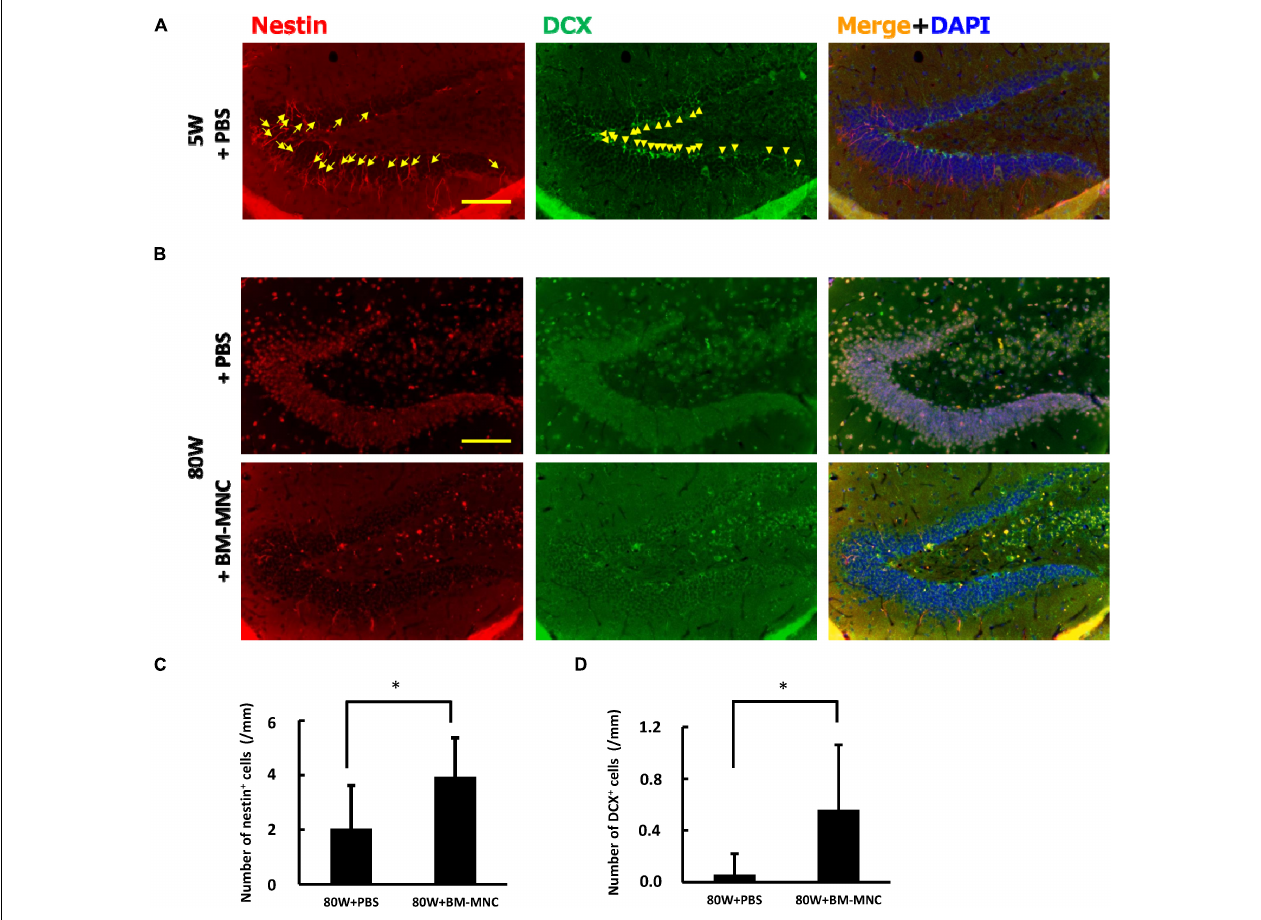
FIGURE 5 | BM-MNC transplantation activates age-related impaired neurogenesis at hippocampus. (A) A large number of Nestin-positive (arrow) and/or DCX-positive (allow head) neuronal progenitor cells were observed at dentate gyrus in young mice. (B) In contrast, only few Nestin-positive and/or DCX-positive neuronal progenitor cells were observed in aged mice that receive PBS or BM-MNC. (C,D) Quantitative analysis revealed that BM-MNC transplantation to aged mice increased the number of Nestin-positive (C) and DCX-positive neuronal progenitor cells (D) . N = 6 and 7 in PBS and BM-MNC transplanted group, respectively (C,D) . ∗ p < 0.05 by Student’s t -test. Scale bar: 100 µ m (A,B) .